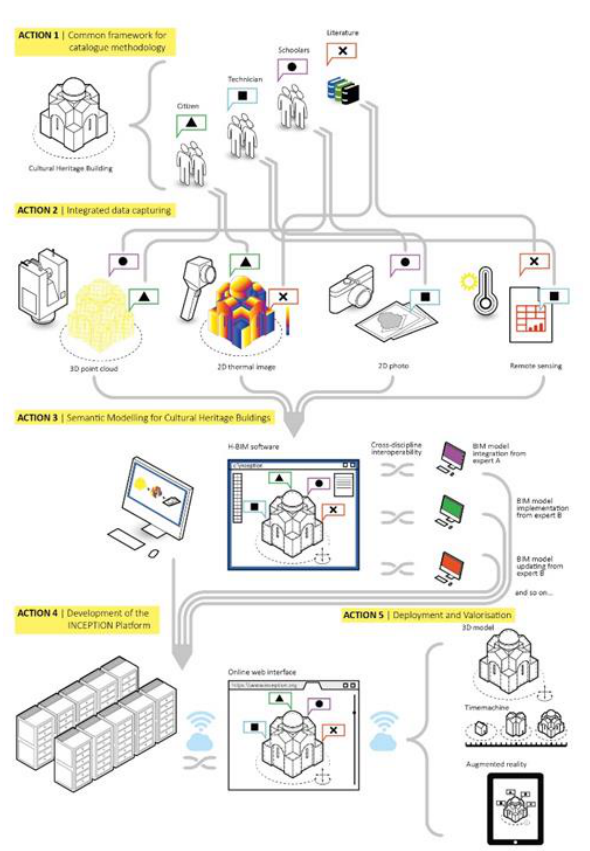
Figure 1. Scheme of the overall project concept and approach divided into five main